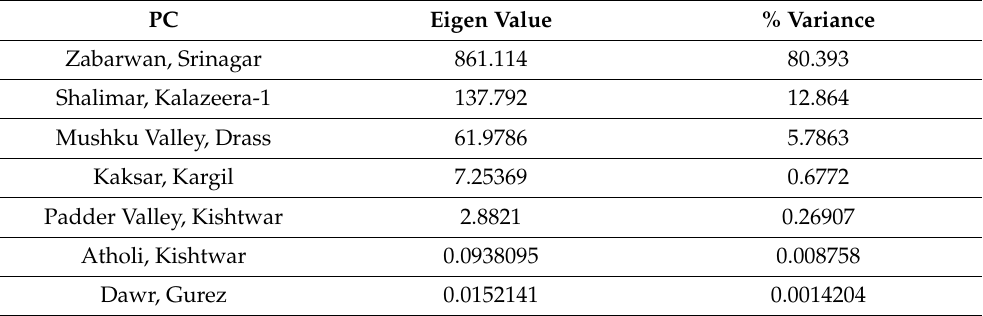
Table 4. Eigen value and percent (%) variance of seven principal component (PC) that includes different climates of Northwestern